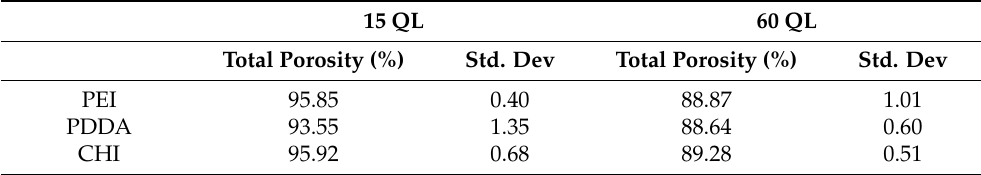
Table 6. Total calculated porosity of PEI, PDDA and CHI coated PU foams ( n = 3) at 15 and 60 QLs.